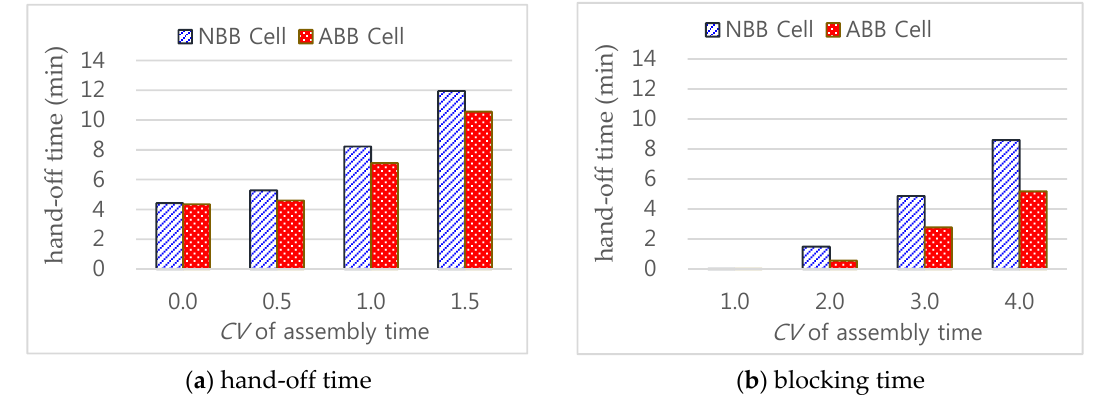
Figure 8. Comparison of the performance of naïve BB-based assembly (NBB) cell and ABB cell in terms of ( a ) hand-off time and ( b ) blocking time.